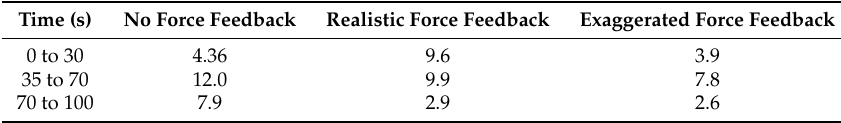
Table 5. % maximum overshoot at different time intervals.